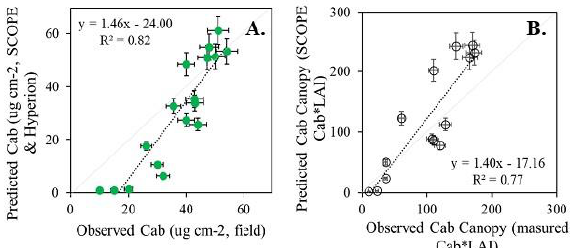
Figure 7. Predicted versus observed leaf total chlorophyll (Cab, A.) and canopy Cab (Cab*LAI, B.), obtained using the SCOPE canopy RTMo in an inversion with Hyperion VSWIR reflectance. Table 2 lists the range and variation of derived traits.